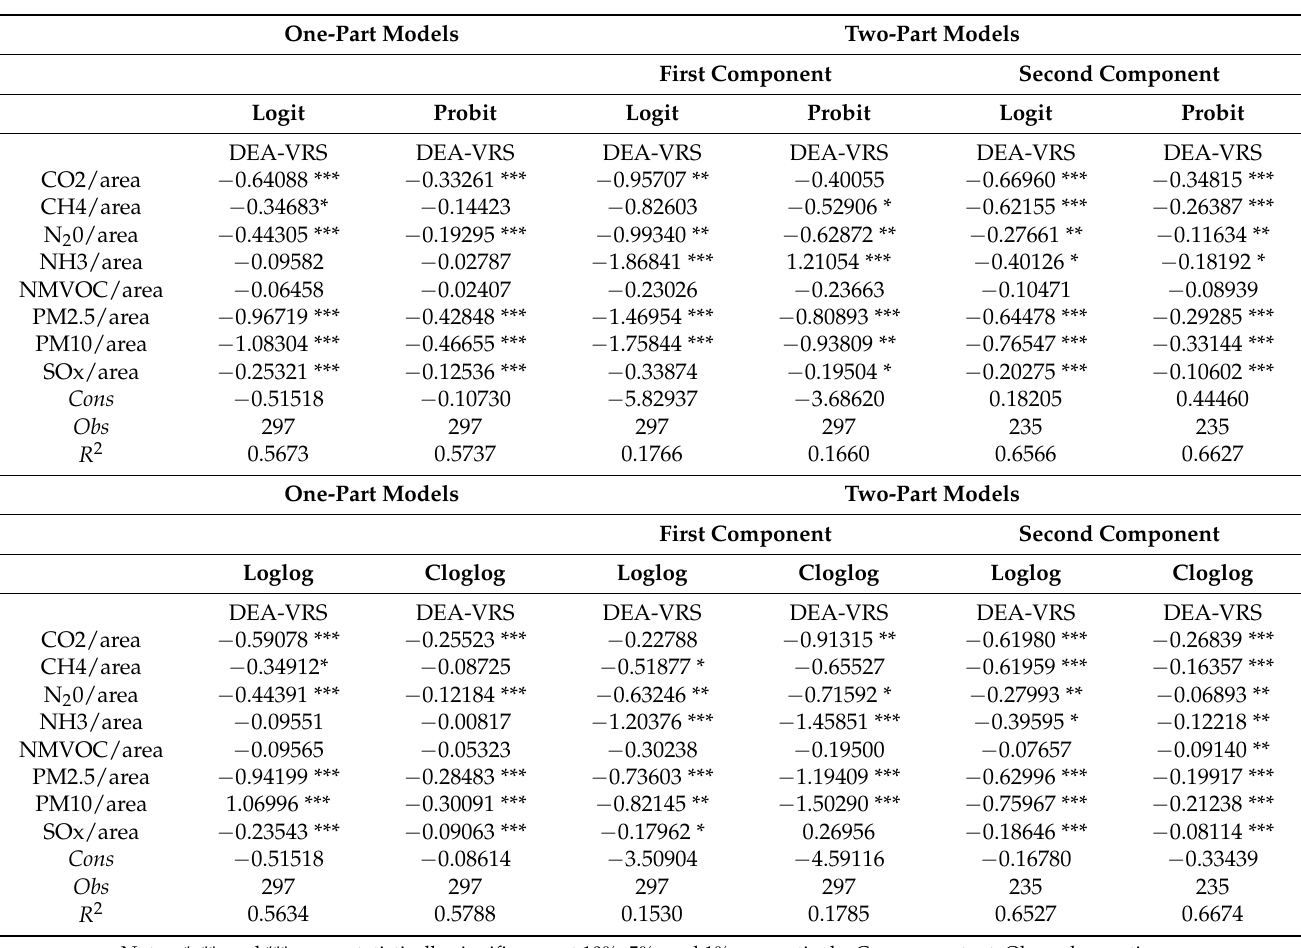
Table 5. Estimation results for the fractional regression model (27 European countries sample): 2008–2018